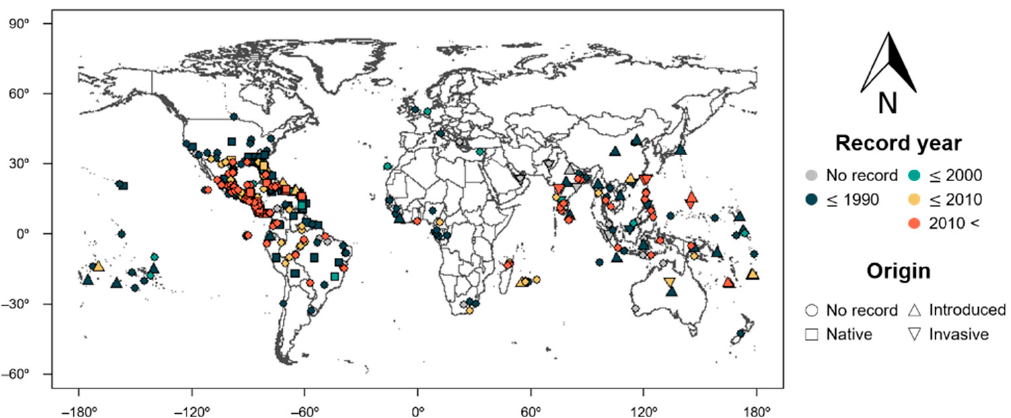
Figure 1. Global distribution of Solenopsis geminata based on databases of the Centre for Agriculture and Bioscience International and Global Biodiversity Information Facility. Different symbols and colors represent the different recorded years and origin of S. geminata , respectively, at each site. The data are available online [12,30] .